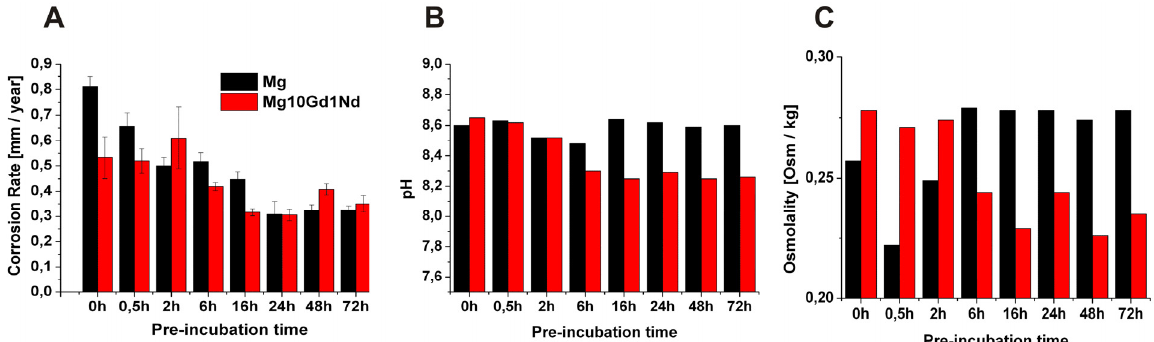
Figure 1. ( A ) Corrosion rate; ( B ) pH values and ( C ) osmolality determined after the indicated pre-incubation